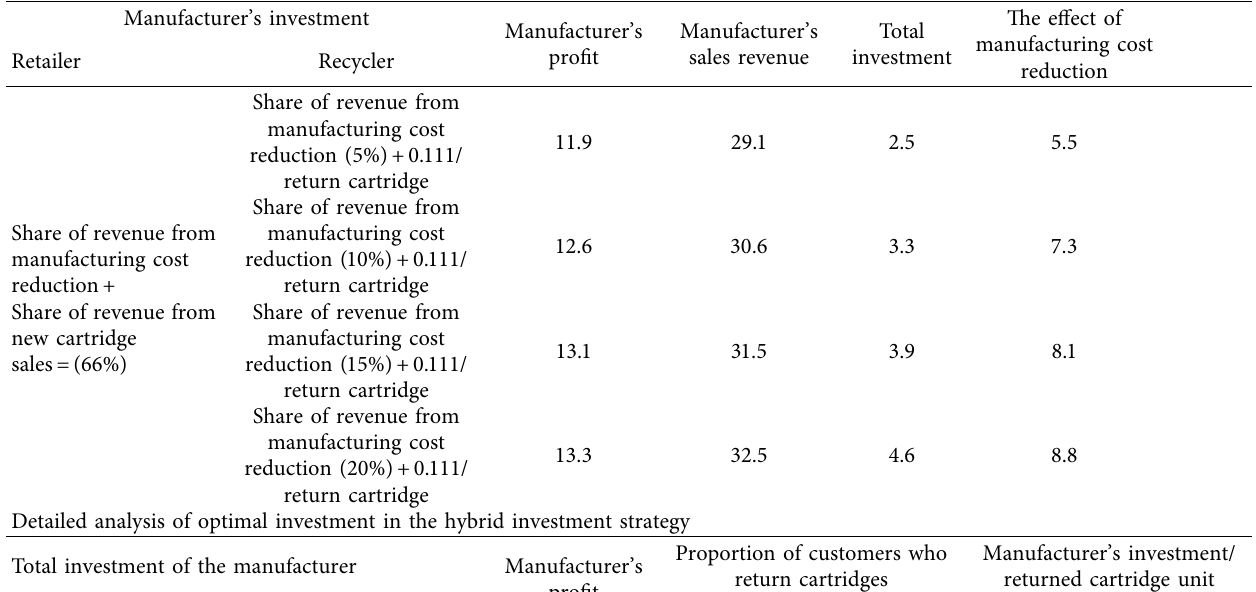
Table 4: The results of the hybrid investment strategy ( s � 0.65, k �